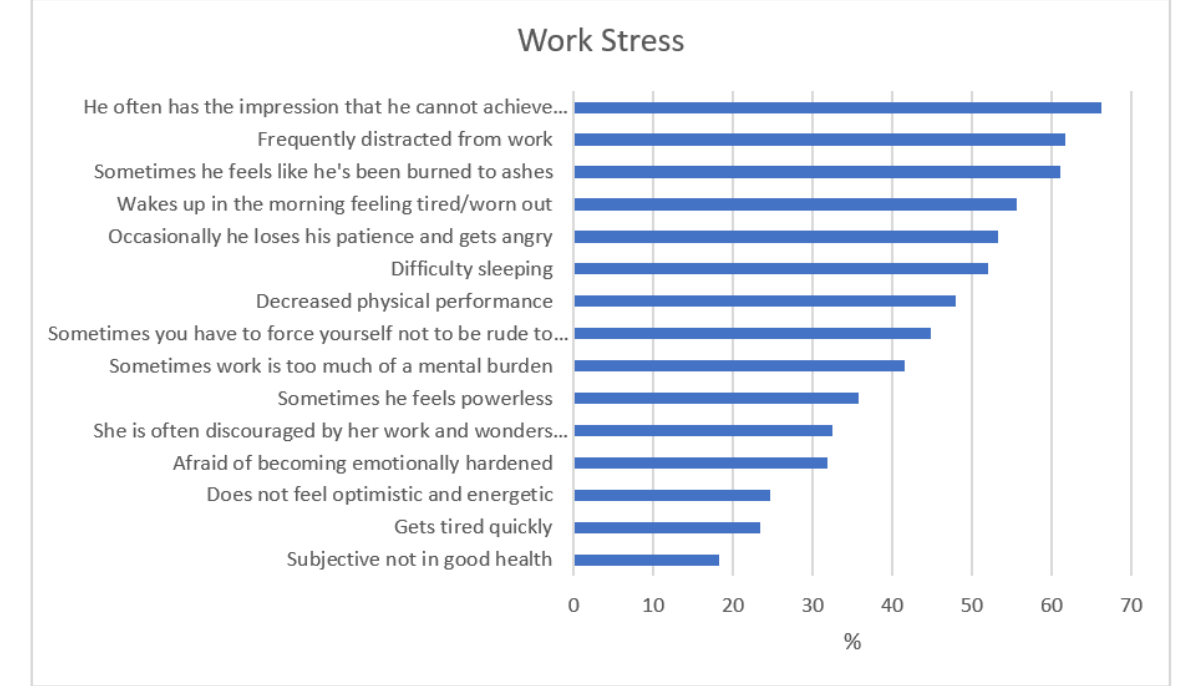
Figure 2. Participants’ answers about work stress, as percentages ( n =